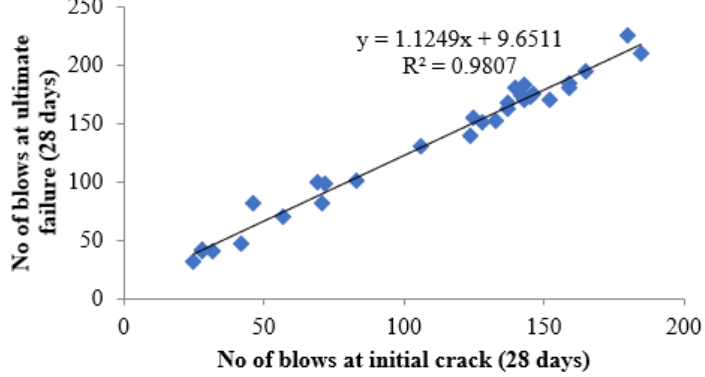
Figure 15. Prediction of ultimate impact resistance at 28